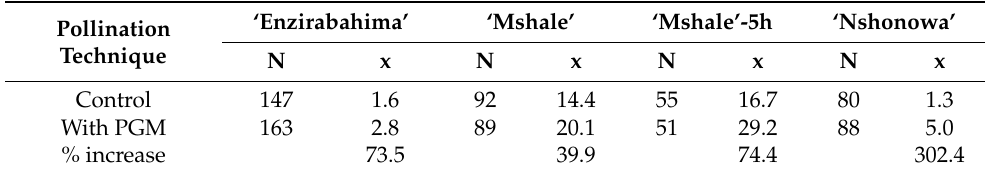
Table 3. Predicted mean seed set per 100 fruits per bunch of two pollination techniques on three East African Highland Cooking bananas.